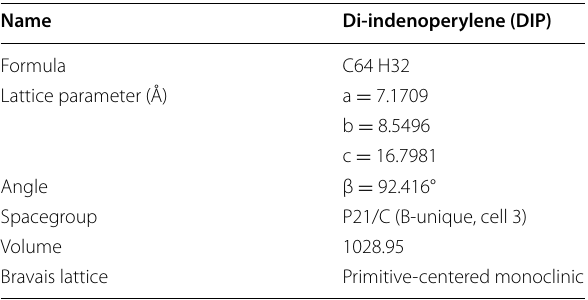
Table 1 Structural properties of the optimized DIP molec-